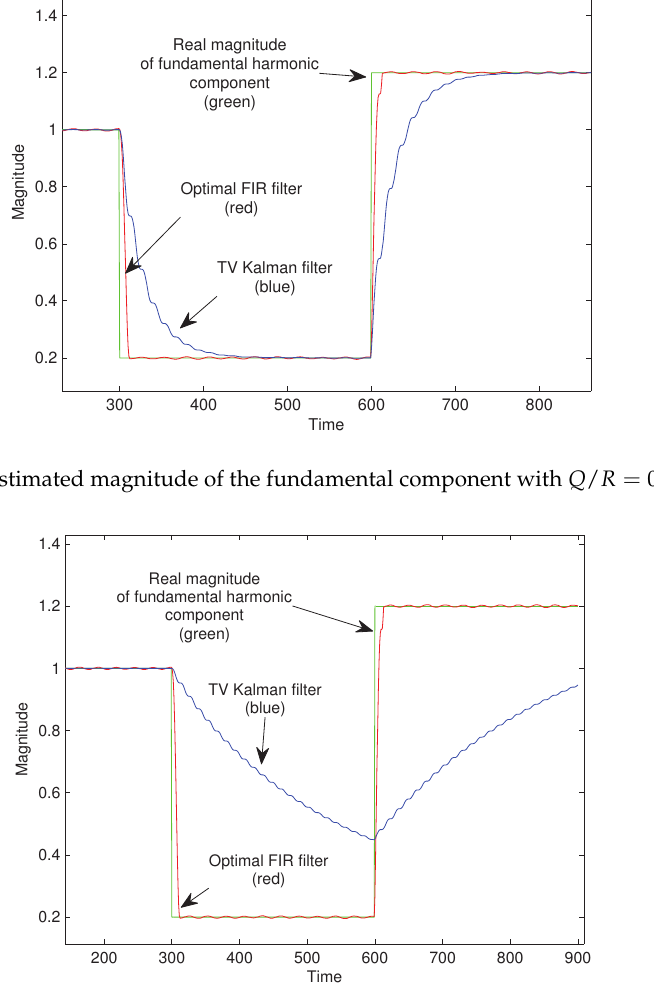
Figure 7. Estimated magnitude of the fundamental component with Q / R =